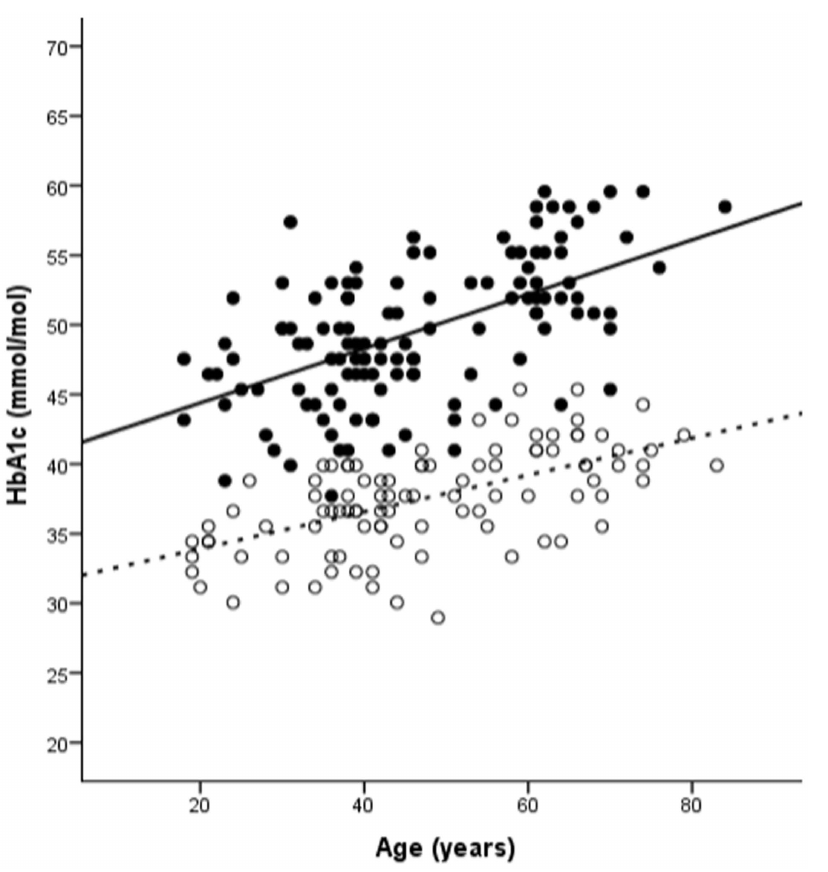
Figure 1. HbA1c increases with age in both GCK and controls. GCK indicated by black circles and black line, controls indicated by white circles and dashed line. doi:10.1371/journal.pone.0065326.g001 above the upper limit of the age-appropriate GCK reference range indicating a GCK mutation could appropriately be ruled out in these cases.